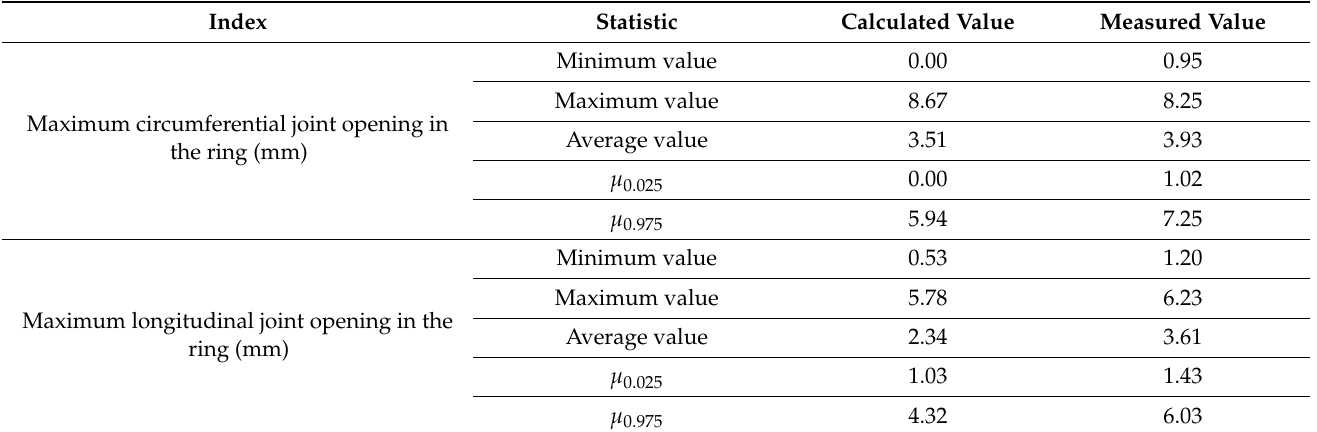
Table 6. Comparison between the calculated values and measured values.